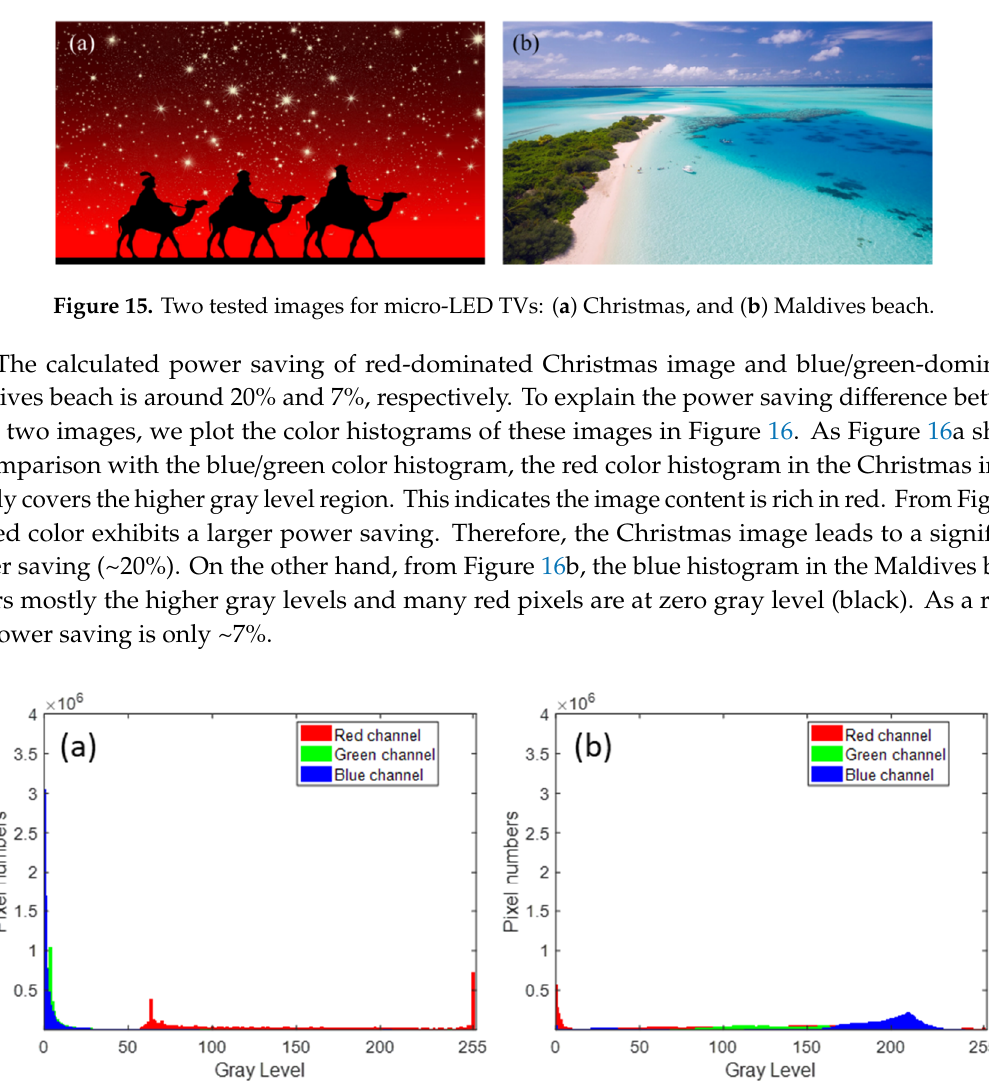
Figure 16. The color histogram of ( a ) Christmas and ( b ) Maldives beach images.